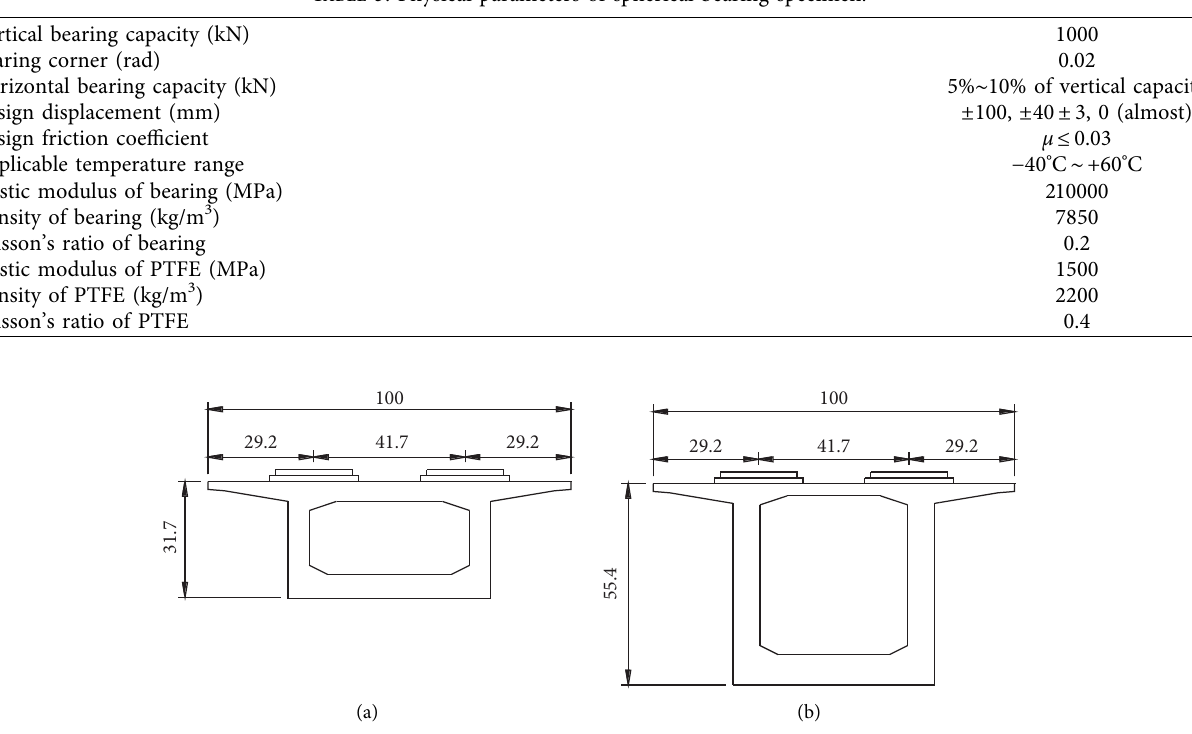
Table 3: Physical parameters of spherical bearing specimen.